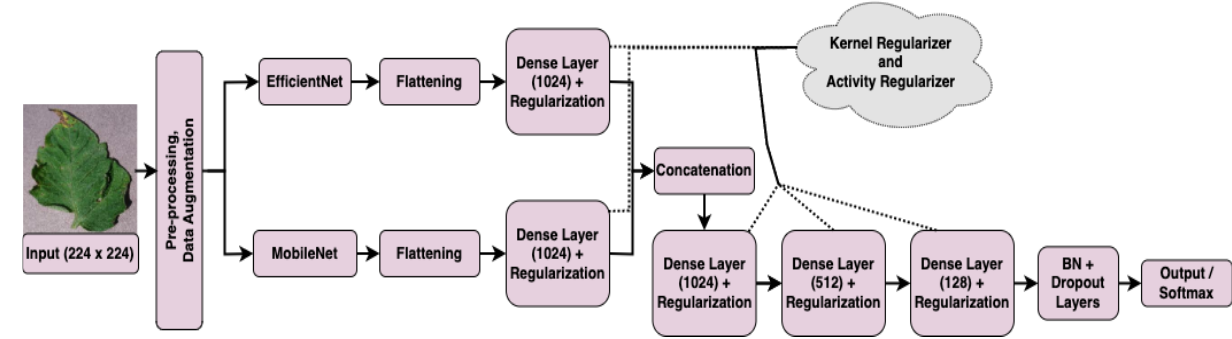
Figure 3. The hybrid EffiMob -Net model architecture proposed in this study.